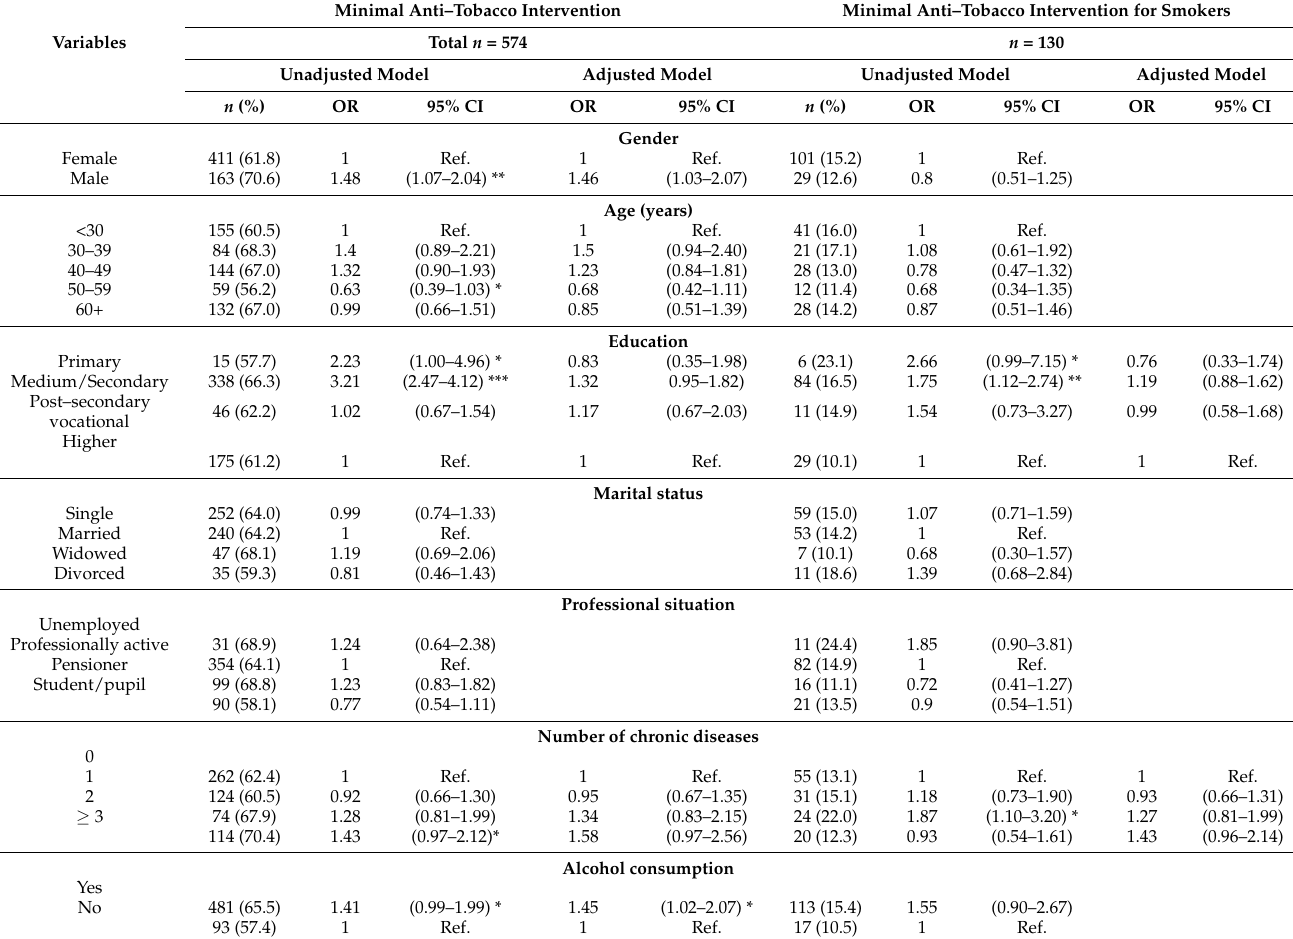
Table 5. The odds ratio of receiving advice from a family doctor according to the analyzed variables (multivariate logistic regression analysis) in